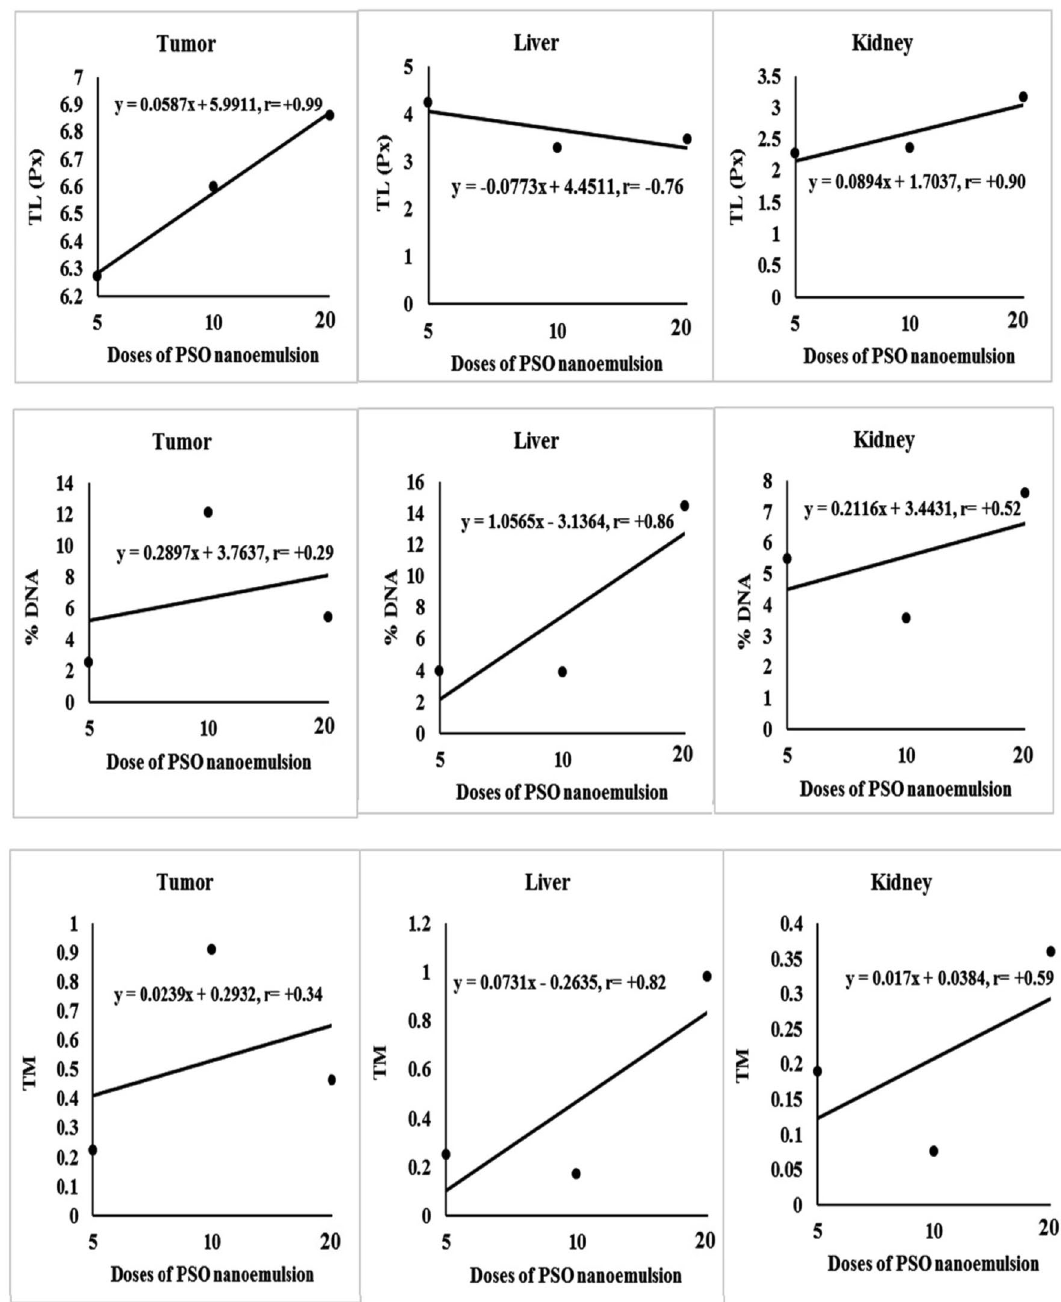
Figure 6. Regression analysis of tail length (TL), %DNA in tail and tail moment (TM) with the different doses of PSO nanoemulsion. r: Pearson’s correlation